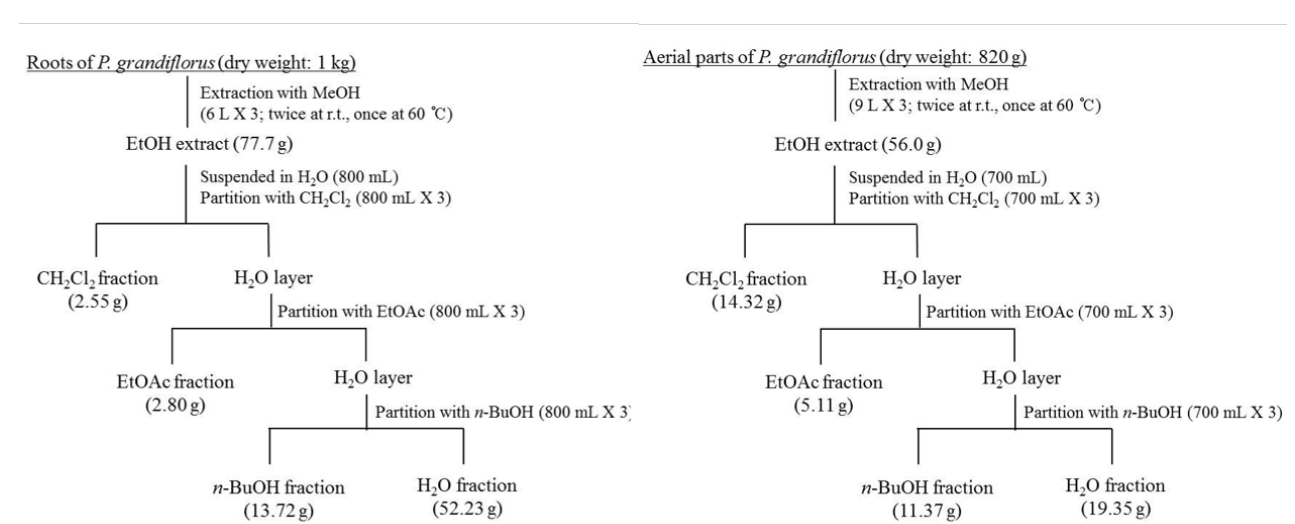
Figure 1. Extraction and solvent partition schemes of the root and aerial part of P. grandiflorus . ( A ) Extraction and fractionation scheme of the root; ( B ) extraction and fractionation scheme of the aerial part.